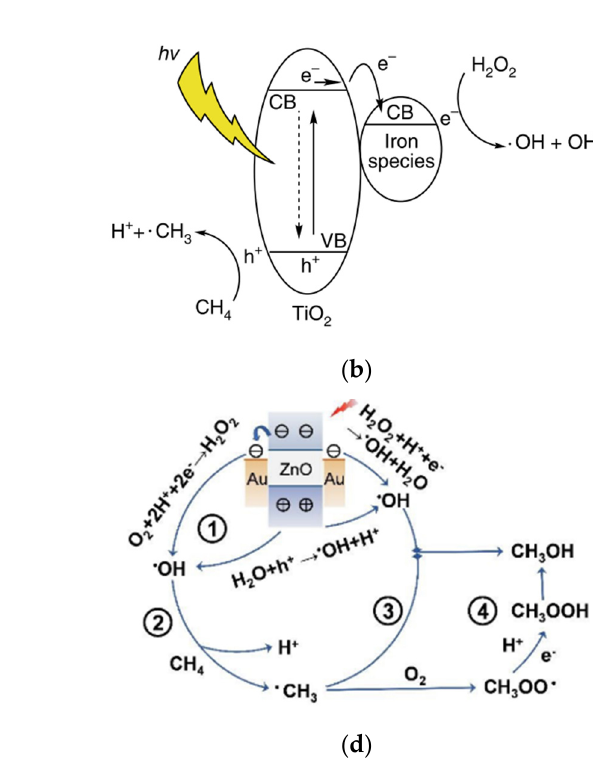
Figure 8. Several proposed schematic mechanisms for selective conversion of methane to methanol were reported by ( a ) Negishi et al. [25], ( b ) Xie et al. [26], ( c ) Zeng et al. [27], and ( d ) Zhou et al.